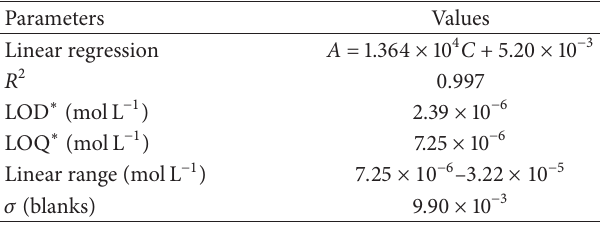
Table 3: Analytical parameters using AOF standards